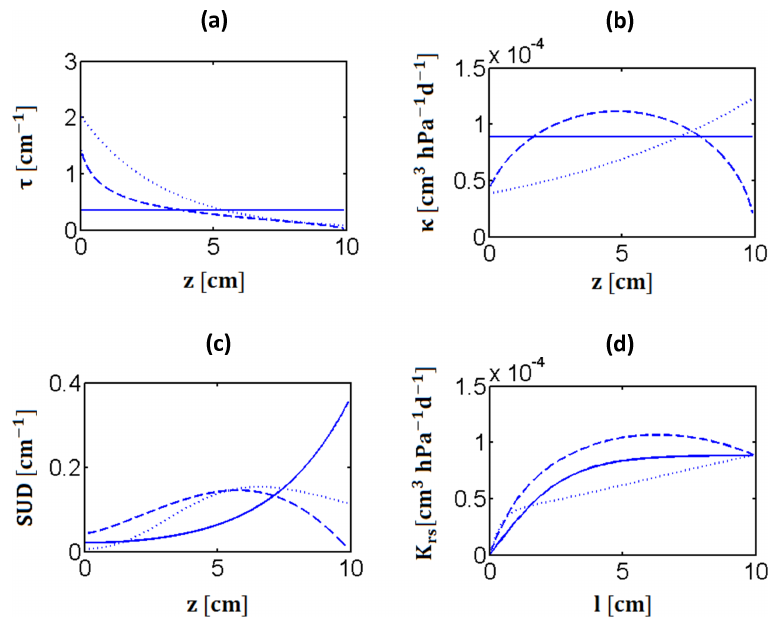
Figure 6. Variation along a single root of root (top line) and macroscopic (bottom line) hydraulic parameters: τ (a) , κ (b) , SUD (c) and K rs (d) of a single root with constant properties (solid blue line), a single root with linear hydraulic profiles (dashed lines) and a single root with exponential hydraulic profiles (dotted lines).